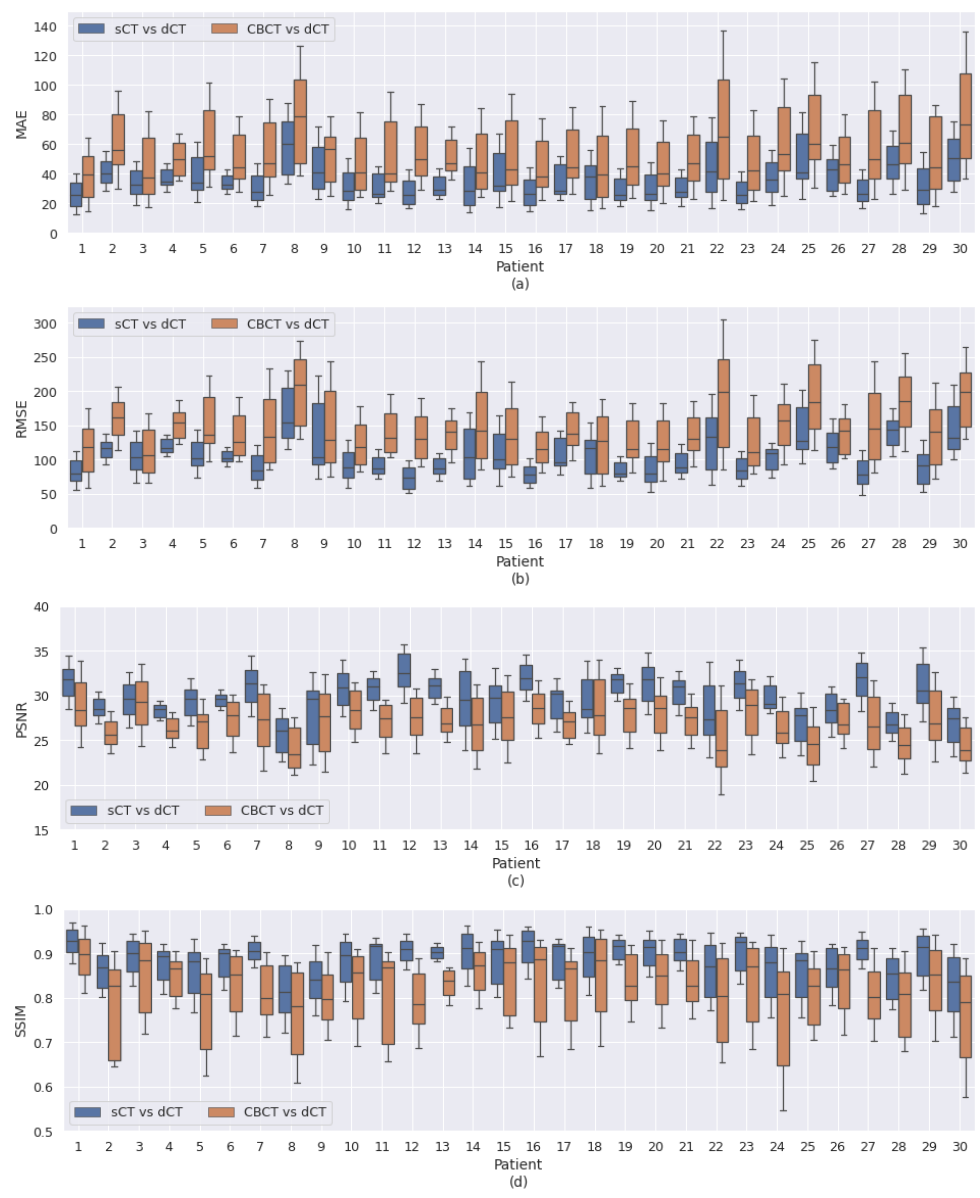
Figure 10. Comparison of sCT with dCT and CBCT with dCT on different similarity metrics, ( a ) MAE, ( b ) RMSE, ( c ) PSNR, and ( d ) SSIM, for each patient in the test set. Values are calculated across all slices from the same